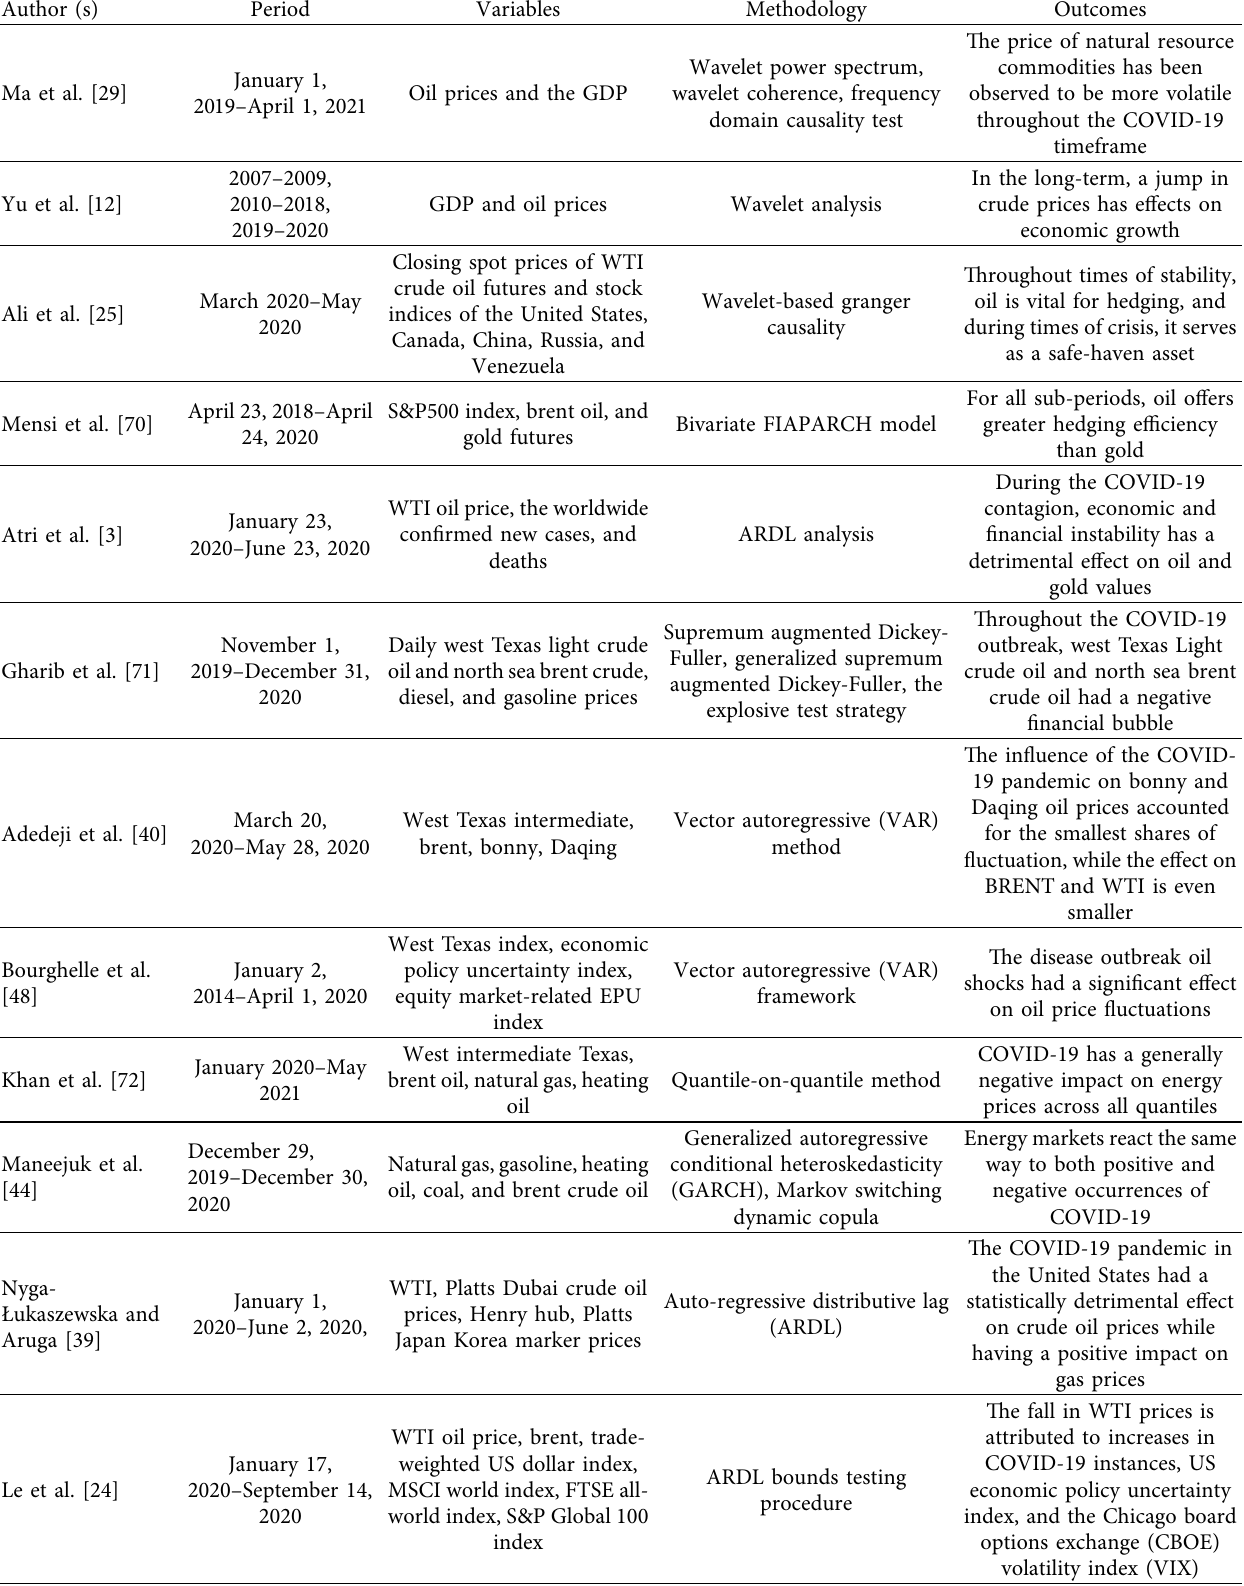
Table 1: Summary of prior literature on the COVID-19–energy market